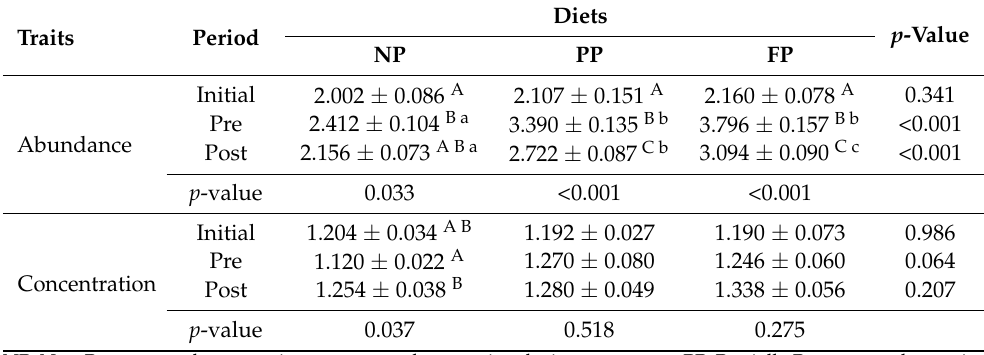
Table 5. Plasma isotope signature of cows from different nutritional strategies and